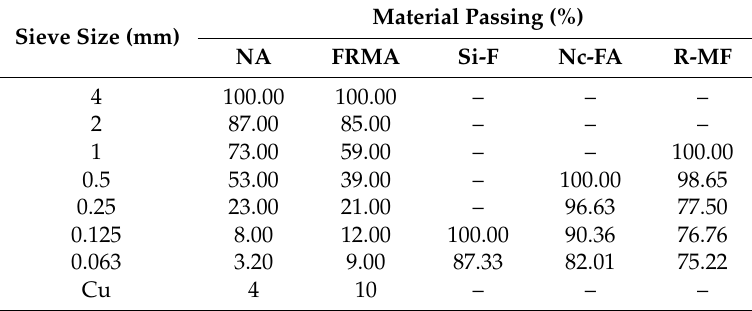
Table 2. Particle size distribution.